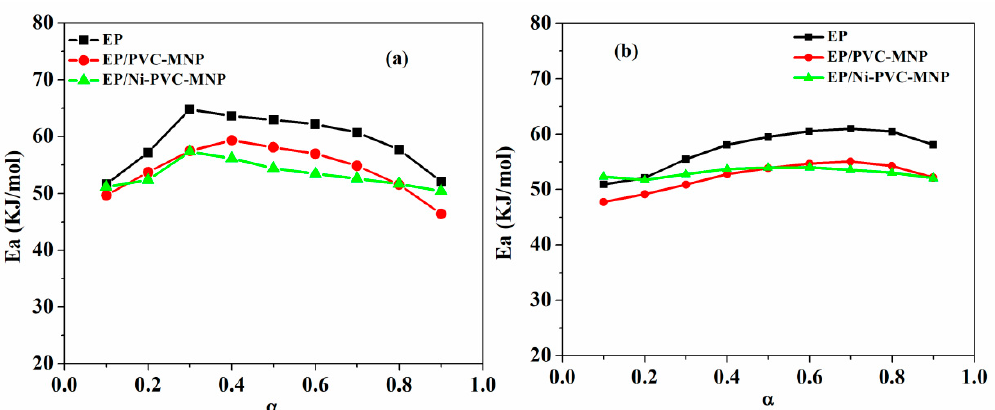
Figure 8. Variation of E α for the EP (reference sample) [50,51] and EP / PVC–MNP and EP / Ni–PVC–MNP nanocomposites calculated by ( a ) Friedman and ( b ) KAS models.